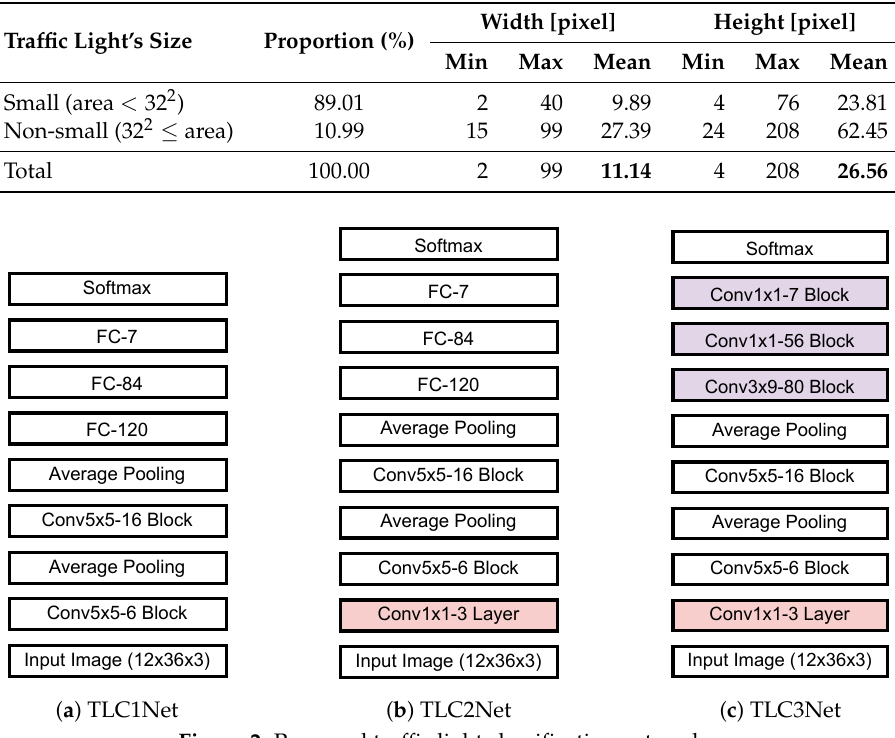
Figure 2. Proposed traffic light classification